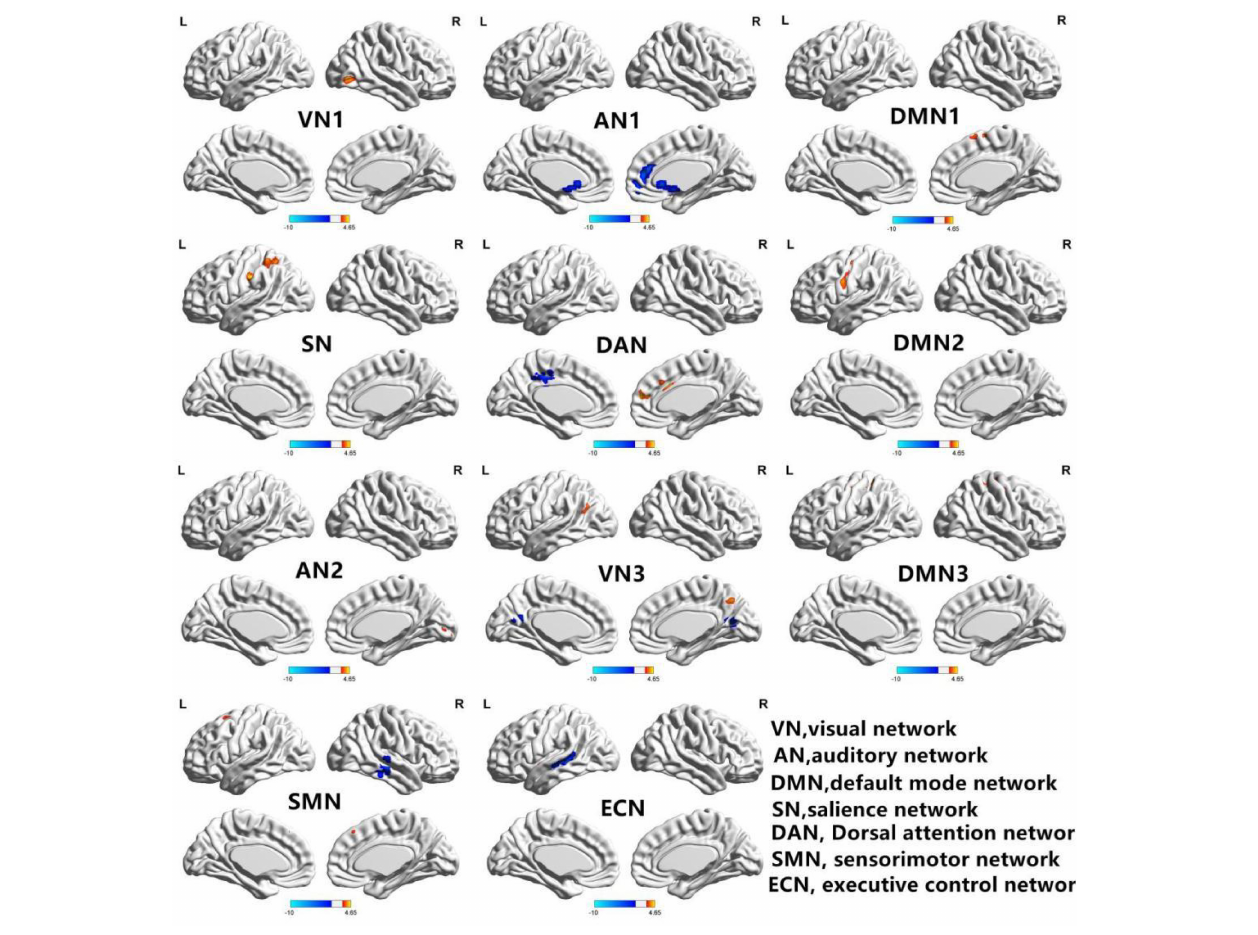
FIGURE 2 | In the HM group, 11 brain regions of RSNs were significantly different ( P < 0.01; GRF correction, cluster-level P < 0.05): visual network 1 (VN1), auditory network 1 (AN1), default mode network 1 (DMN1), significance network (SN), dorsal attention network (DAN), default mode network 2 (DMN2), auditory network 2 (AN2), visual network 3 (VN3), default mode network 3 (DMN3), sensorimotor network (SMN), and executive control network (ECN). BrainNet Viewer images show increased (warm colors) and decreased (cool colors) FC connectivities in the HM group.